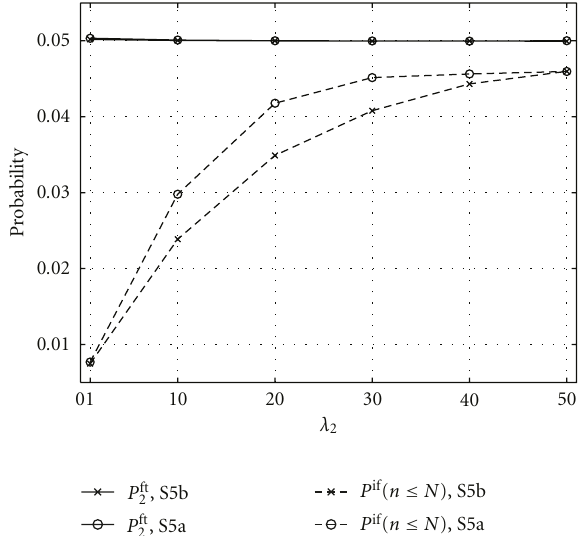
Figure 6: P ft 2 and interference ( P if ( n ≤ N )) with λ 2 in S5a and S5b.